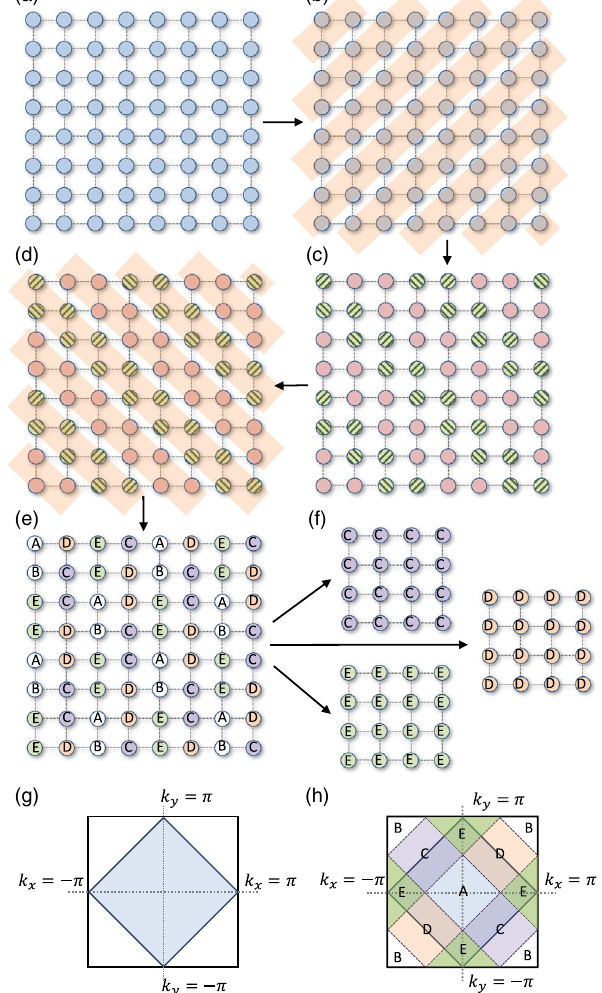
FIG. 6. One layer of the branching MERA for two-dimensional free fermions. (a) The 2D lattice of fermionic modes. (b) A series of 1D wavelet transformations, as depicted in Fig. 1, applied diagonally. (c) Lattice sites corresponding either to scaling (solid) or wavelet (striped) outputs from the preceding transformations. (d) A series of 1D wavelet transformations applied across the other diagonal. (e) The lattice, which now contains five different types of sites (labeled A – E). (f) Sites A and B, differentiated by the application of Hadamards and truncated, with new sublattices formed separately from sites C – E. (g) The Brillouin zone of the 2D free fermions, where the shaded region denotes the Fermi sea. (h) The sites in (e), approximately corresponding to the distinct regions of the Brillouin zone as shown. Sites A and B contain modes in the occupied j 1 i or unoccupied j 0 i states, respectively, and may be truncated. Sublattices from sites C and D consist of products of 1D chains that are only correlated in the back-sloping diagonal or forward-sloping diagonal directions, respectively. The sublattice from site E is self-similar to the original